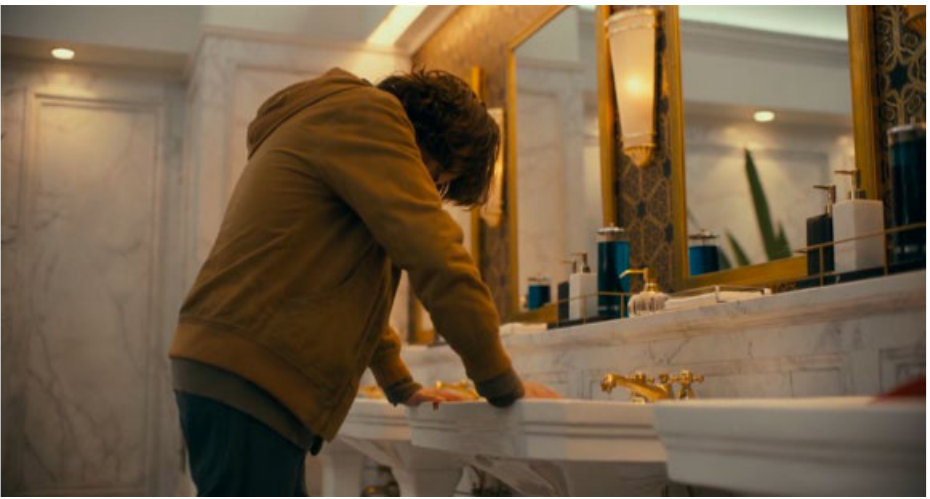
Figure 10 Shot immediately preceding refrigerator